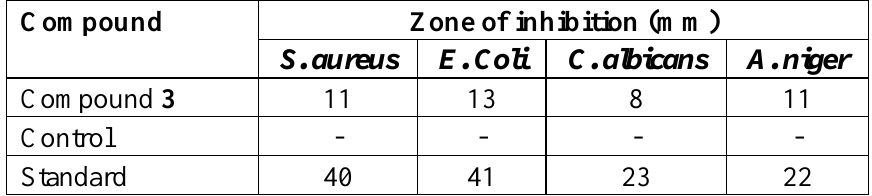
Table 1. Antimicrobial activity data of the synthesized